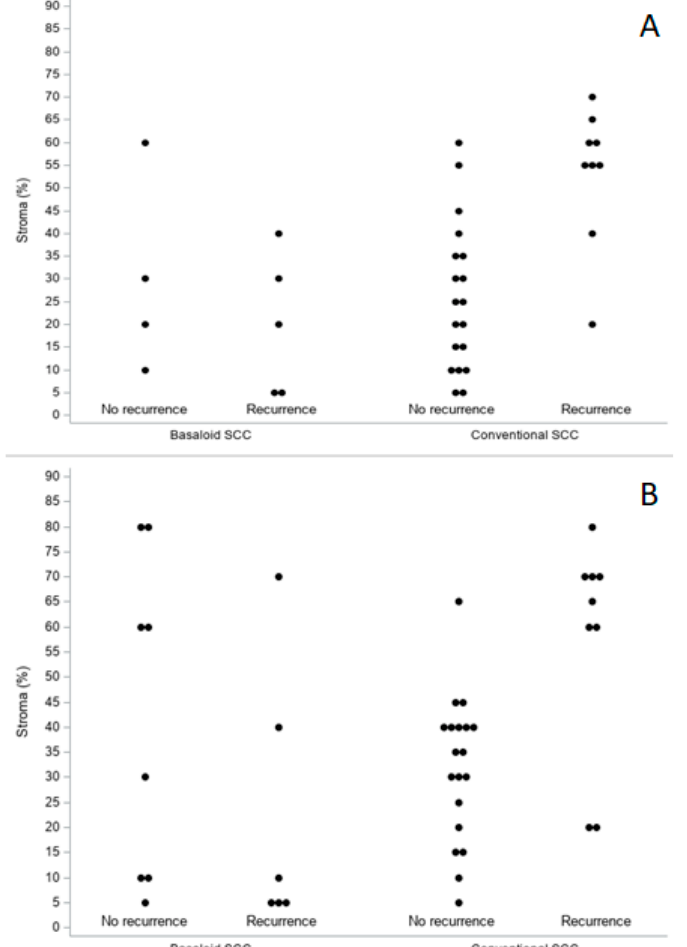
Figure 5. Biopsies ( A ) and surgical specimens ( B ). TSR distribution (percentage of stroma) by histology and prognosis.